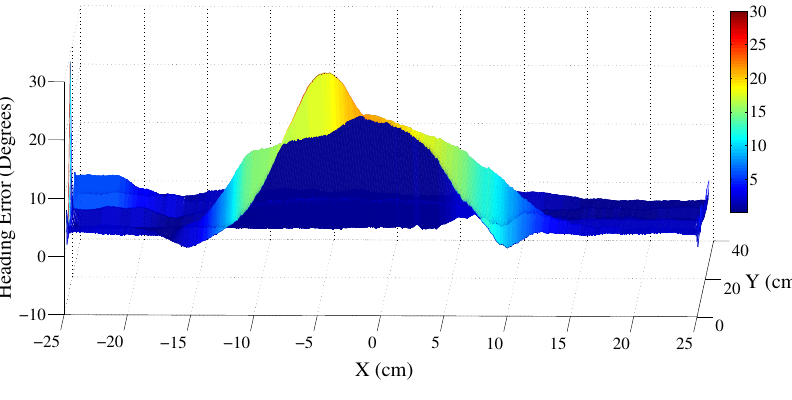
Figure 4. Magnitude of orientation error when the AHRS is moved in a linear trajectory across a magnetic object.